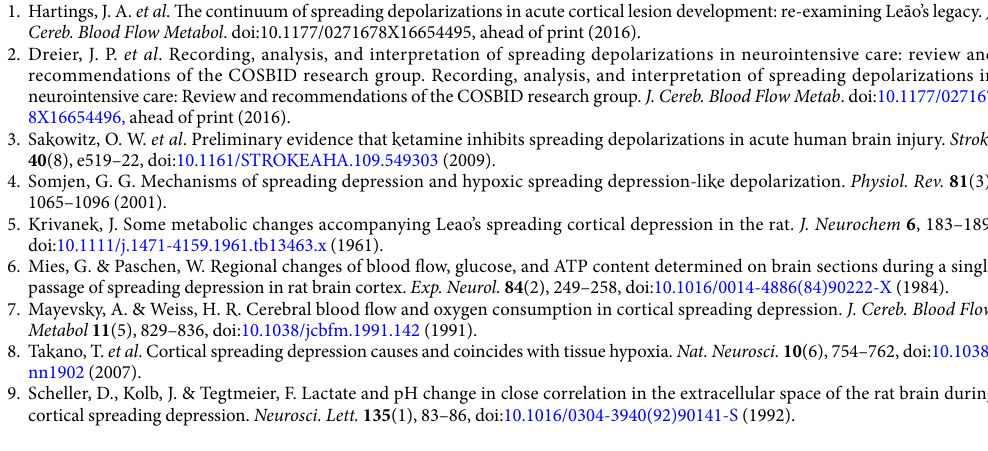
11 Scientific RepoRts | 7: 1154 | DOI:10.1038/s41598-017-01284-4